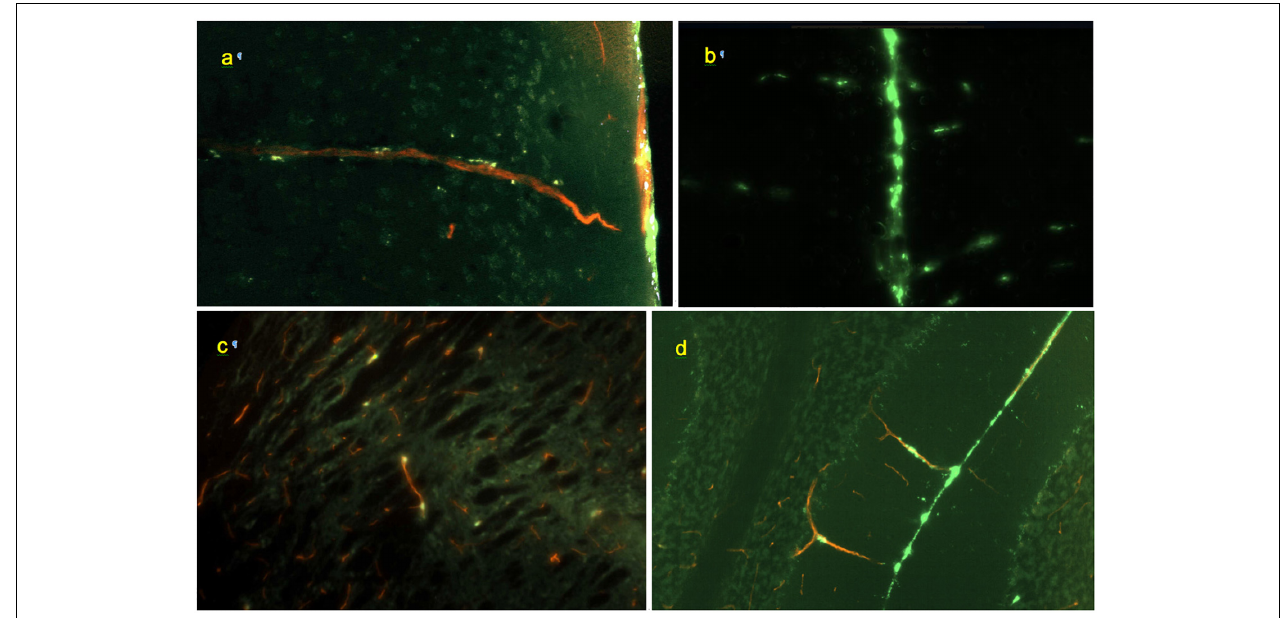
FIGURE 4 | Morphology of perivascular conduits (green: FITC-rhNAGLU, red: blood vessels stained with Texas Red, cyan: cell nuclei stained with Hoechst 33342). (a) Frontal cortex, vessel entrance from the external surface of the brain; 0.6 mm × 0.4 mm, sagittal plane. (b) Conduits (horizontal linear patterns) extending from the longitudinal fissure (vertical line in the center), 0.9 mm × 0.6 mm, coronal plane. (c) Scattered labeling of internal perivascular compartment in caudate putamen; sagittal plane, 0.3 mm × 0.2 mm. (d) Cerebellar fissure and perivascular conduits extending through the molecular cell layer to the Purkinje cells and granular cell layers, 0.9 mm × 0.6 mm, coronal plane. Unstained, unfixed 20 µ m